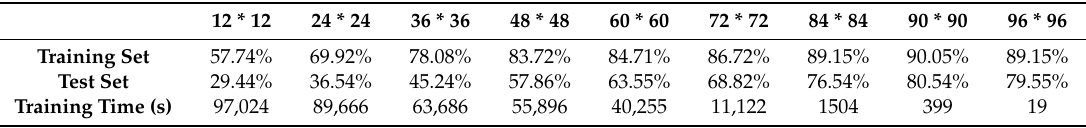
Table 6. E ff ects of di ff erent sliding panes sizes on accuracy and training